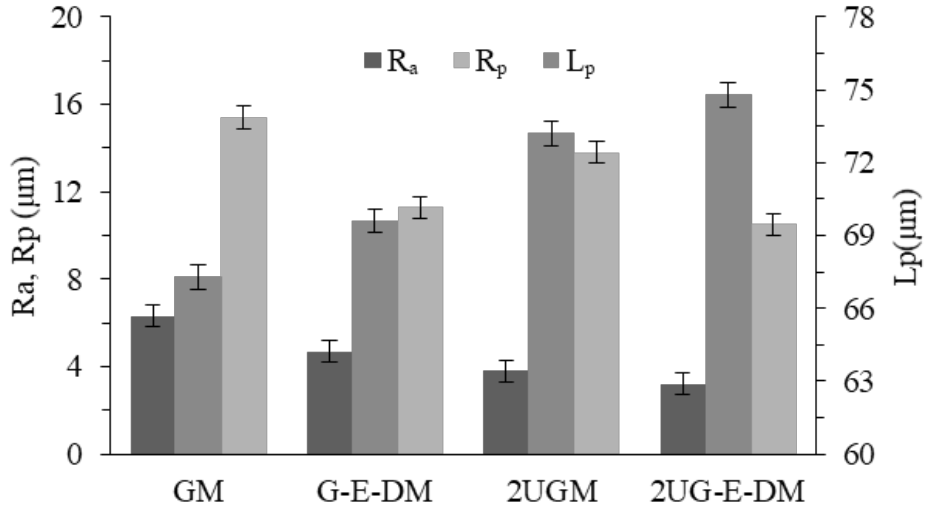
Figure 9. The surface topography parameters of different processes. The change law of surface roughness values under different amplitudes is shown in Figure 10. As the amplitude of the workpieces and tools increases, Ra decreases signifi- cantly, and the relationship between the workpiece vibration and the surface roughness is almost linear, while the effect is weaker at a smaller tool amplitude. As the amplitude of the workpiece increases, the dragging displacement of the base particles enhances, the area ratio of the rolling area and the width of the groove increase year-on-year, the resid- ual height between the abrasive particles reduces, and the processed surface improves. ( a )